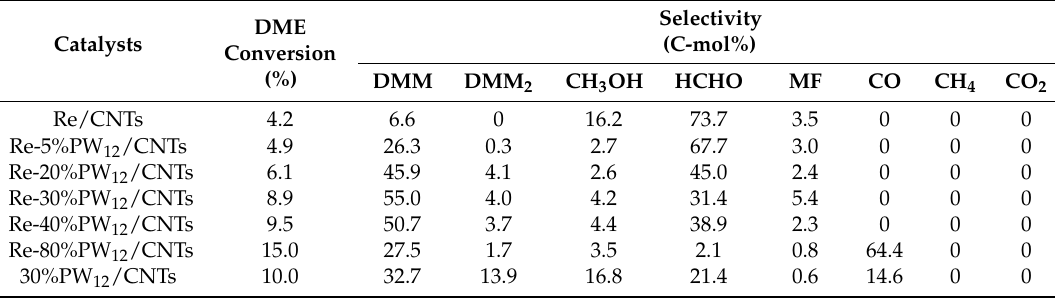
Table 1. Effects of PW 12 content on the performance of 5%Re-PW 12 /CNTs.